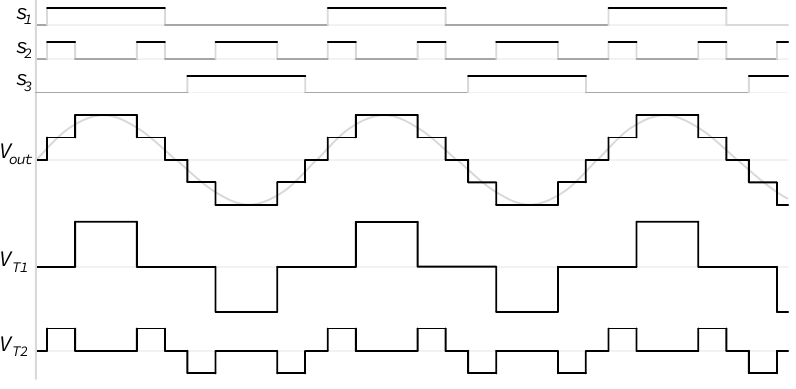
Figure 20. Important signals of the converter operation. From top to bottom: firing signals, output voltage, and voltage in transformers T 1 and T 2 .